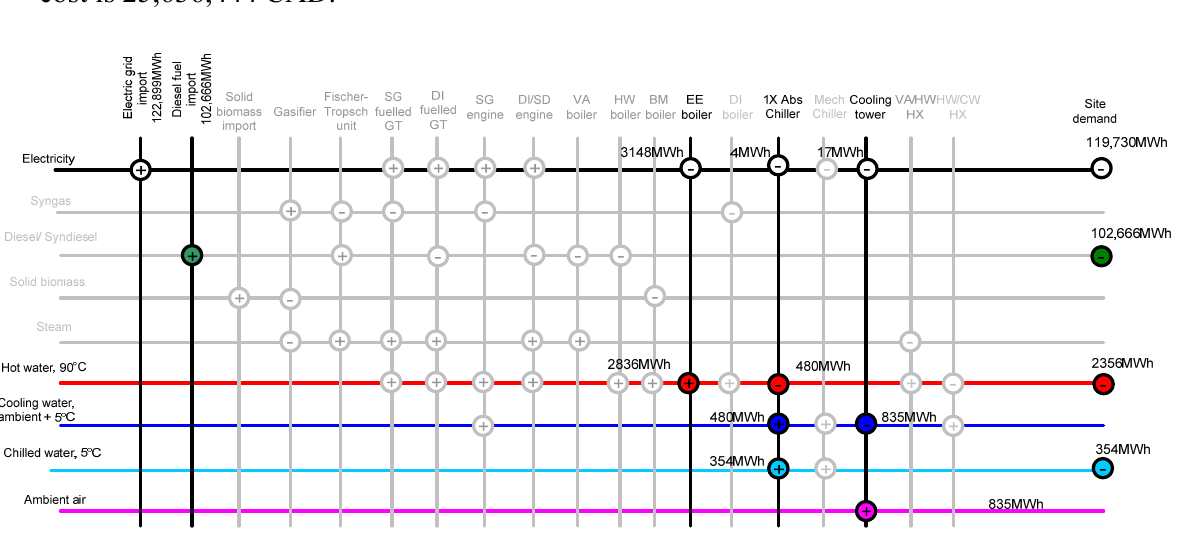
Figure 8. Optimal base case solution, displaying technologies installed and main annual energy flows. The annuitized capital cost is 140,070 CAD, and the annualized operation cost is 25,636,444